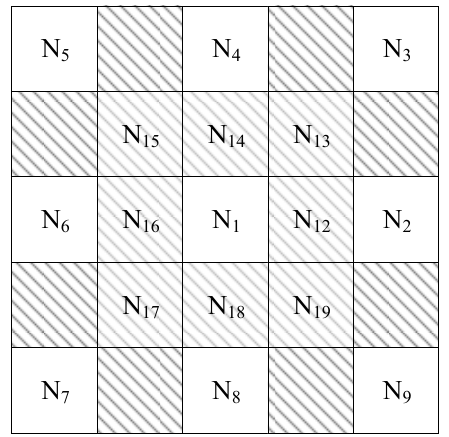
Figure 5. Schematic diagram of coordinate design.